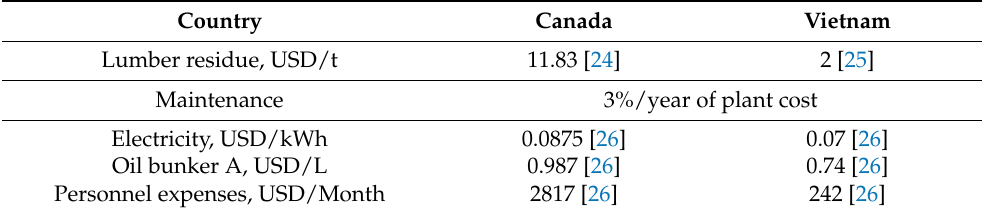
Table 3. Assumption of O&M